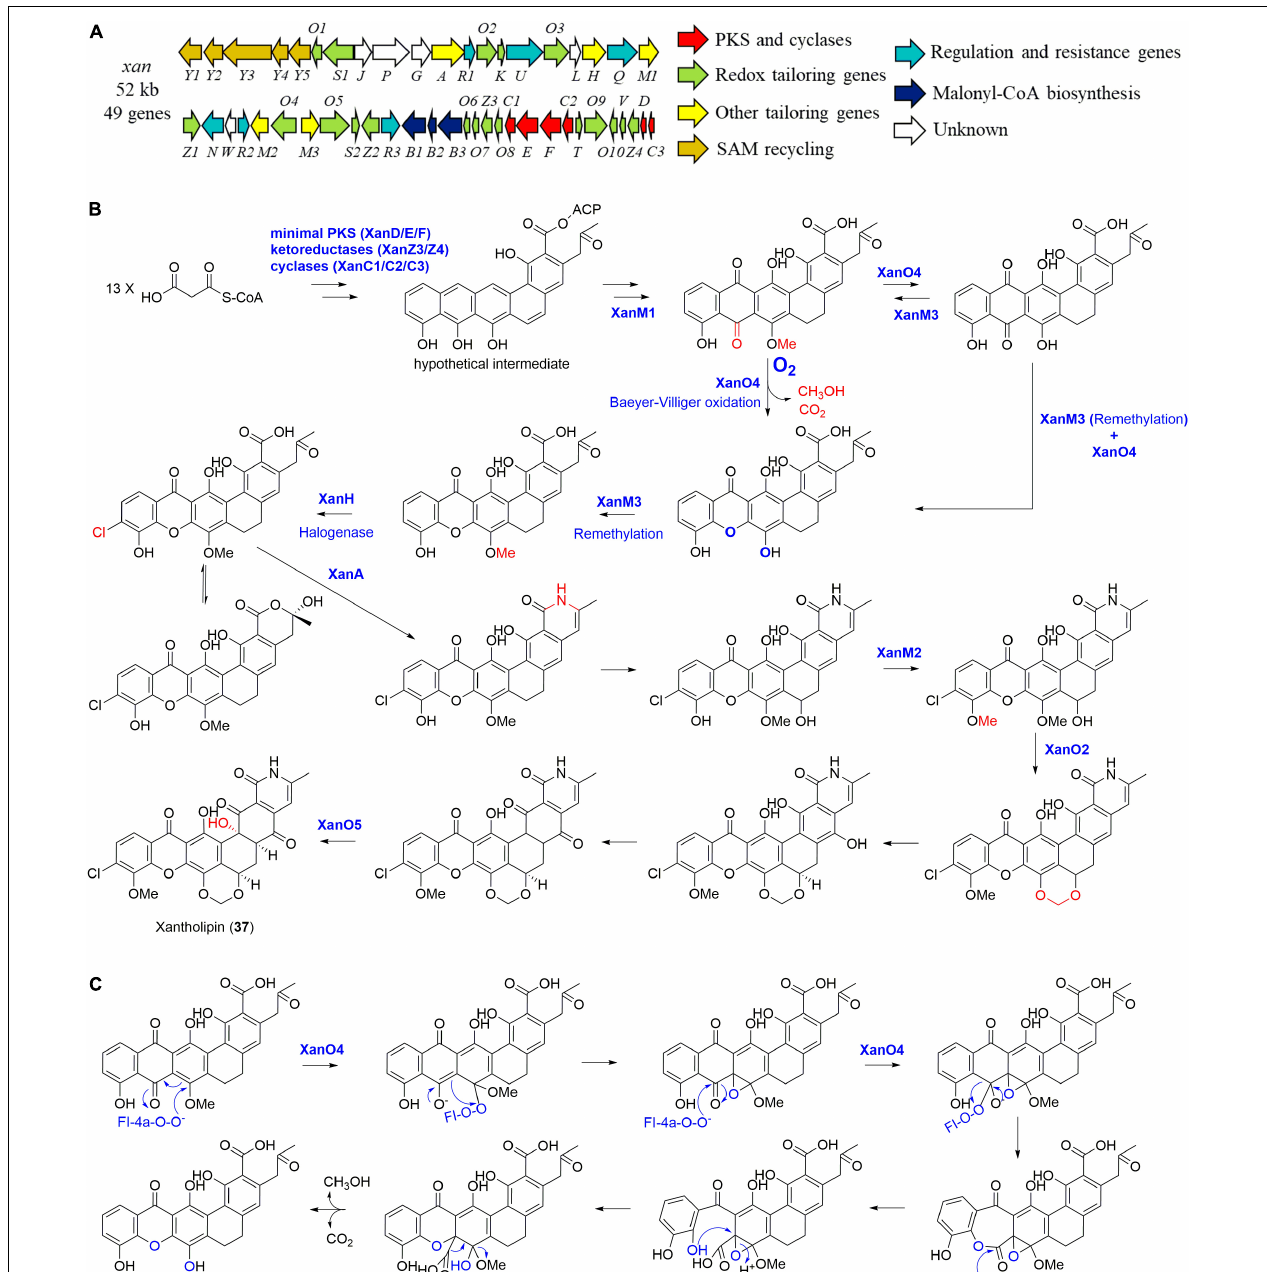
FIGURE 9 | The biosynthesis of xantholipin ( 37 ). (A) The gene cluster (xan ) of compound 37 ; (B) the proposed biosynthetic pathway of compound 37 ; (C) the possible enzymatic mechanism of the multifunctional monooxygenase XanO4.